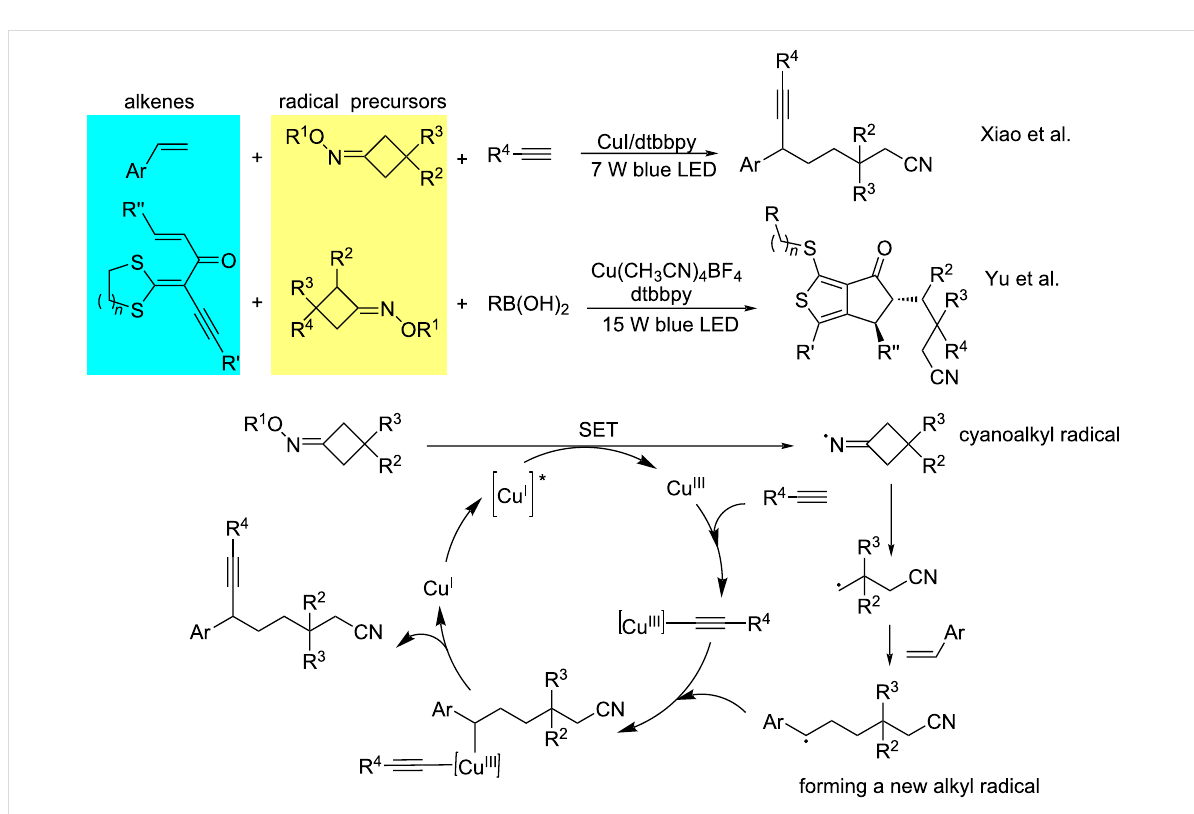
Scheme 12: Cross-coupling of alkenes with oxime